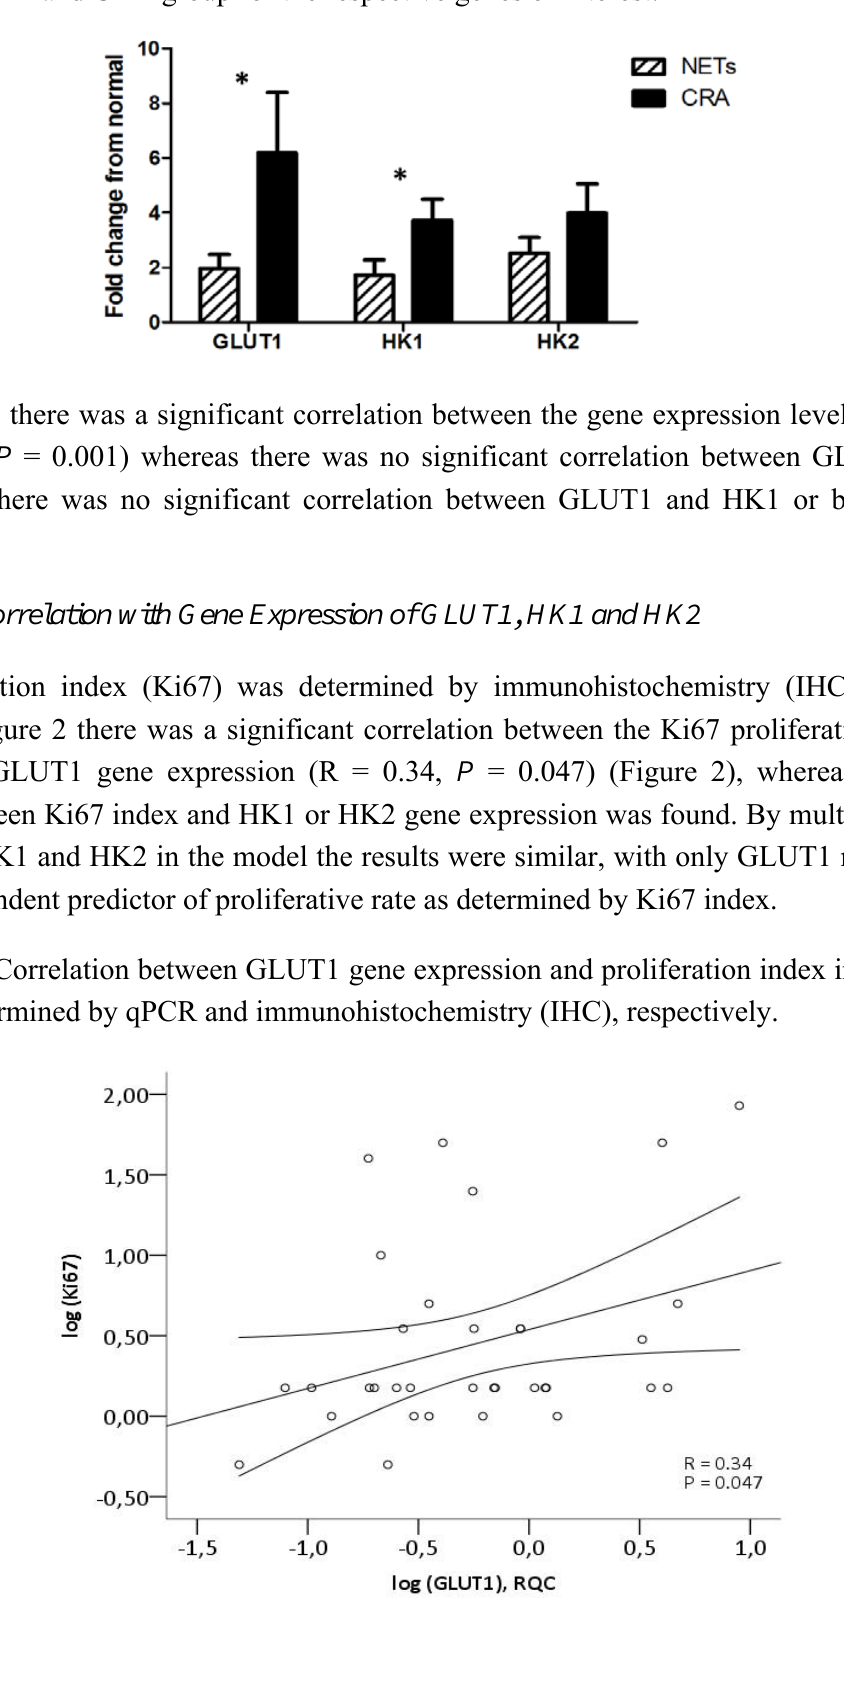
Figure 1. Gene expression level of glucose transporter 1 (GLUT1), and hexokinases (HK) HK1 and HK2 in the NET group (black bars) and the colorectal adenocarcinoma (CRA) group (grey bars). Error bars are expressed as S.E.M., ( * ) significant difference ( P < 0.05) between NET and CRA group for the respective genes of interest.